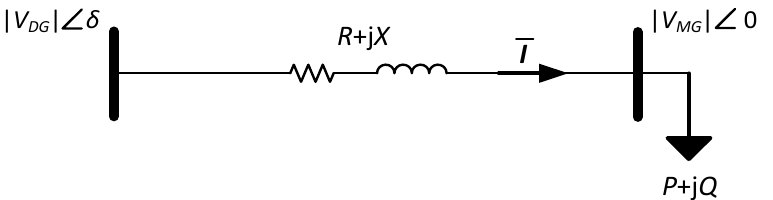
Figure 1. Simple 2-bus power system model to prove the concept of the islanding detection method.